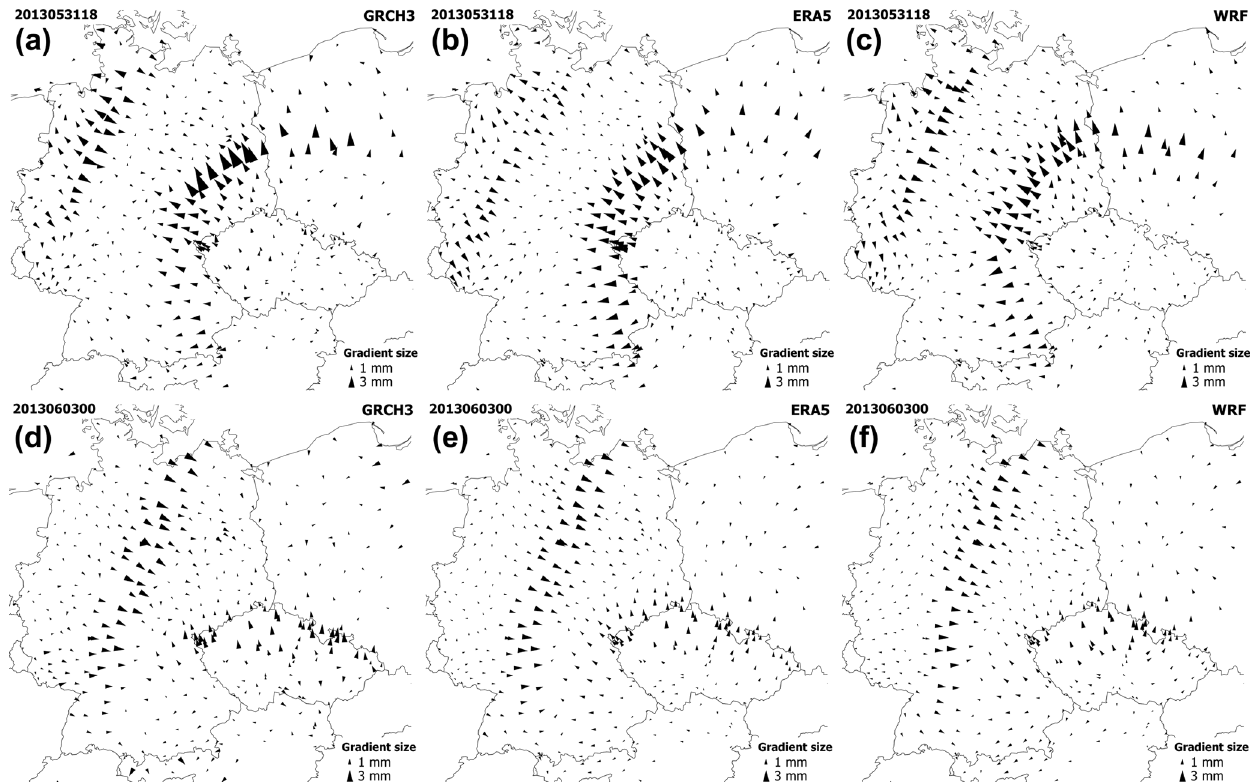
Figure 3. Tropospheric gradient maps from the GNSS GRCH3 solution (a, d) , NWM ERA5 solution (b, e) and NWM WRF solution (c, f) on 31 May 2013, 18:00UTC (a, b, c) and on 3 June 2013 00:00UTC (d, e, f)